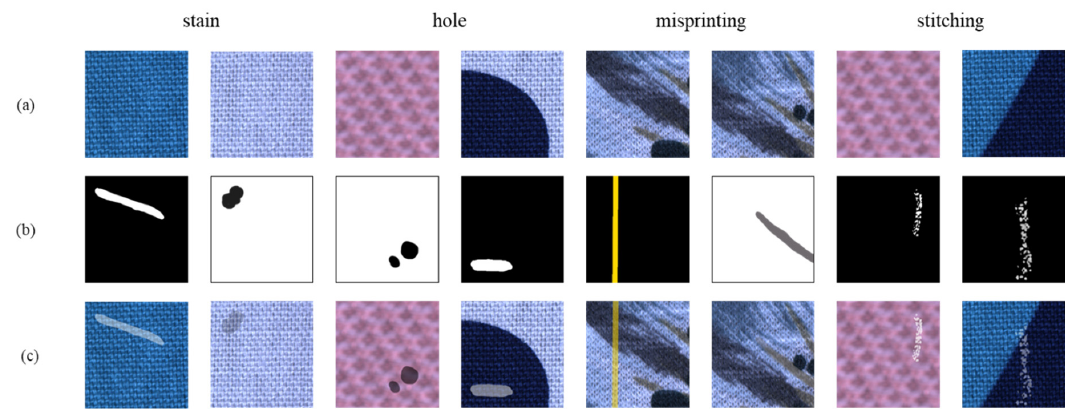
Figure 3. Samples of the generated synthetic defects in our experiment: ( a ) non-defect images, ( b ) generated synthetic defect images, and ( c ) defect applied images.